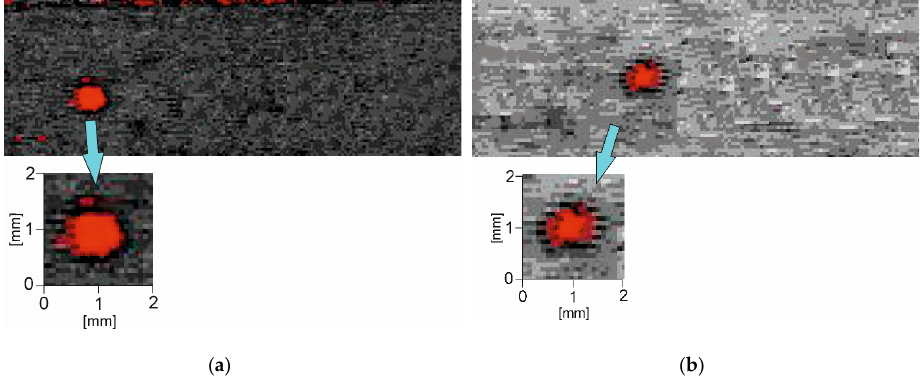
Figure 4. C ‐ scan images obtained by through ‐ transmission method for ( a ) CFRP and ( b ) GFRP. Figure 4. C-scan images obtained by through-transmission method for ( a ) CFRP and ( b ) The red fields in Figure 4 indicate the location of real internal defects (not introduced artificial internal defects as in our previous paper [45]) which are visible as disturbances during scanning. For the CFRP composite sample, we detected a real defect of 1.3 mm